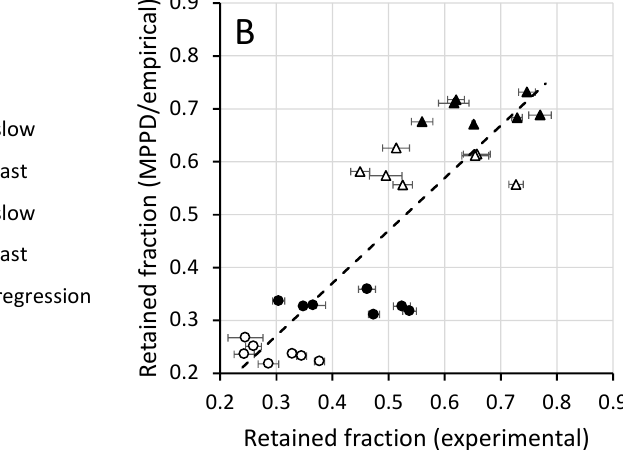
Figure 8. Comparison of retained fraction predicted by the MPPD/empirical and MPPD/CFD mod- els with measurements of Darquenne et al. [20]. In silico predictions were obtained for subject-spe- cific breathing conditions matching the experiments. Data are shown as the median (minimum, maximum) of the 7 healthy subjects. *: significantly different from experiments ( p < 0.02). See text for details.